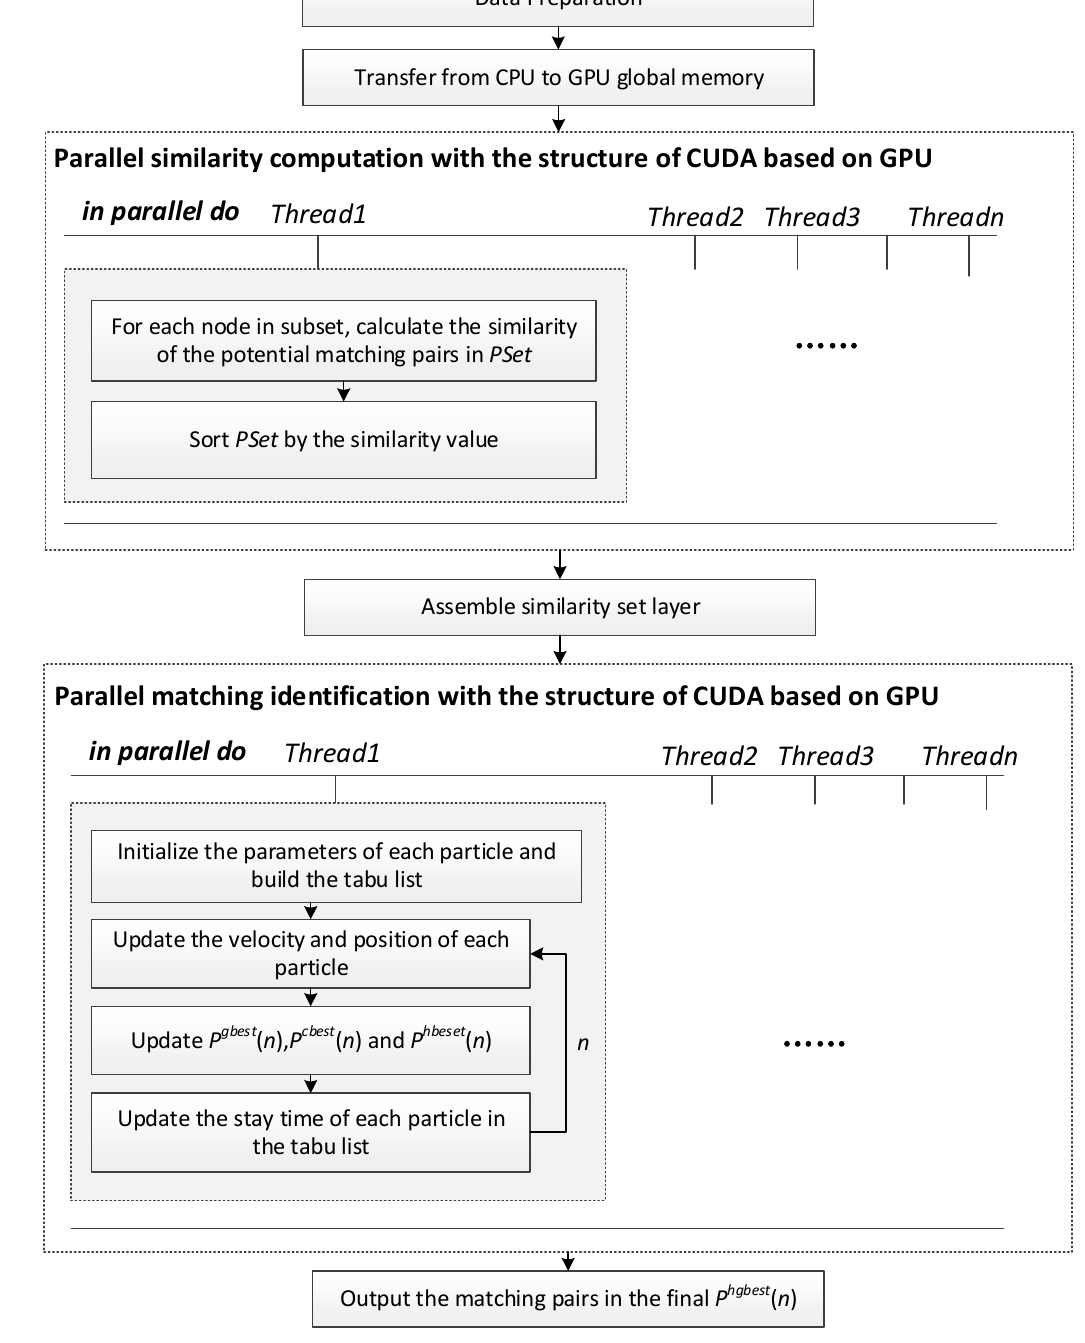
Figure 3. Particle-swarm optimization-based matching (PSOM) parallelization strategy.